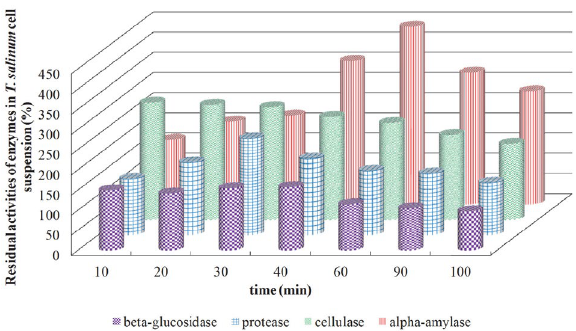
Figure 5: Residual activity of various enzymes in the T. salinum cell suspension in relation to homogenization time at 35 °C and a ho- mogenization speed of 25,000 rpm. Experiments were repeated three times. Standard deviation for all measurements was less than ± 3%.